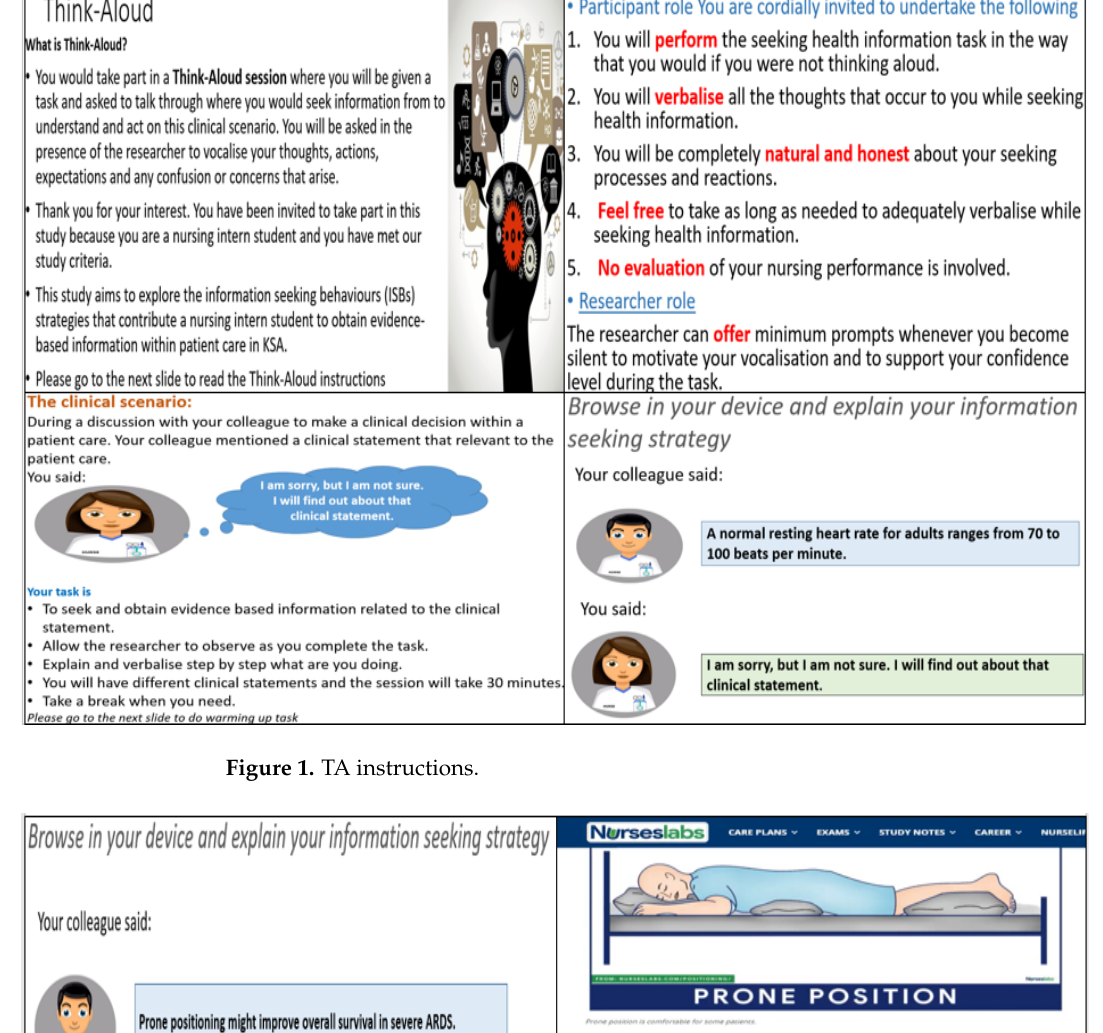
Figure 1. TA instructions.